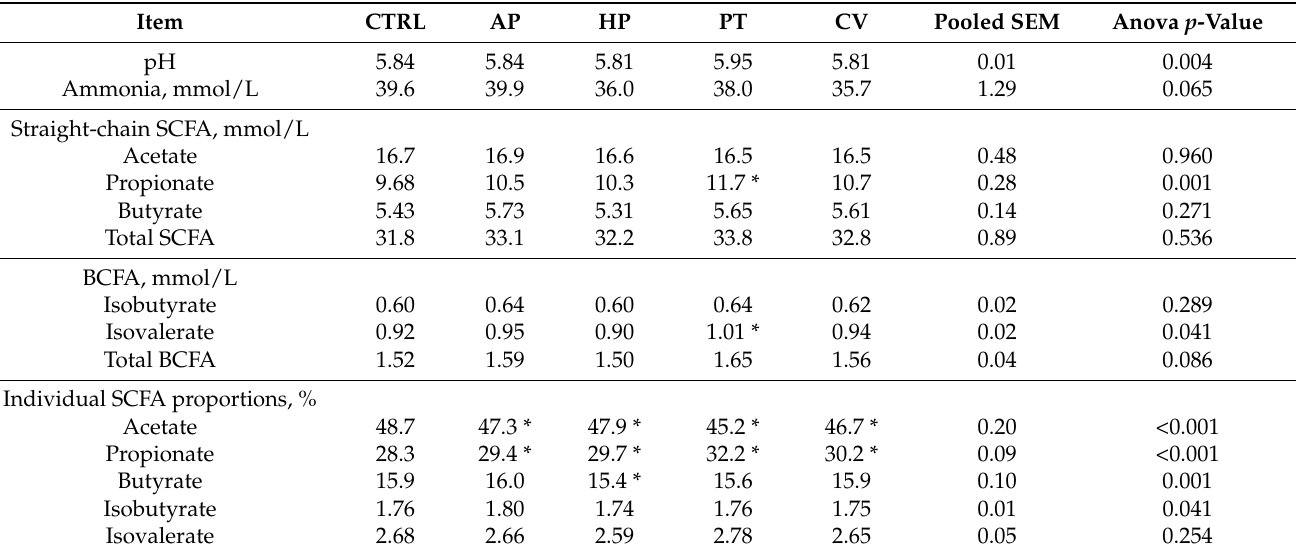
Table 5. pH values, ammonia and short-chain fatty acids concentrations after 24 h of an in vitro incubation of canine fecal inoculum supplemented with microalgae 1